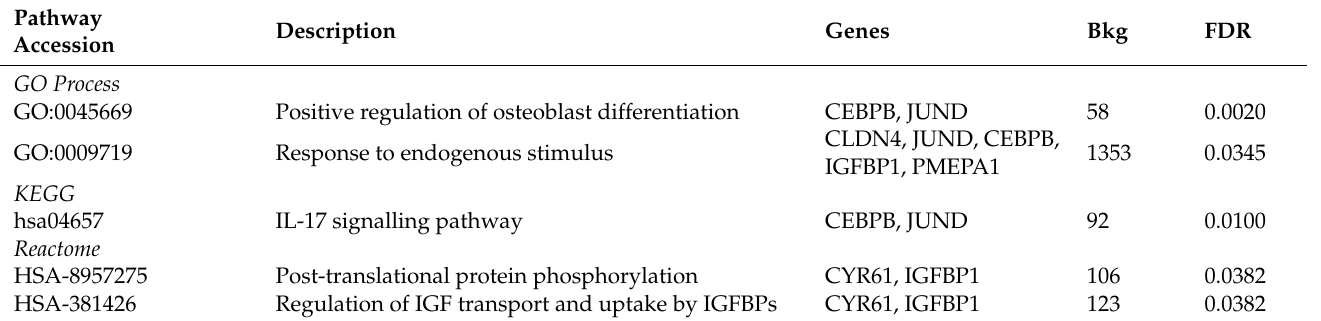
Table A9. Enriched pathways amongst upregulated PSC genes over pseudo-time. This Table summarises the pathways identified as being over-represented in the protein network presented in Figure A12. The pathways explored included Gene Ontology (GO) biological processes, KEGG pathways and Reactome pathways. Abbreviations: Bkg, Background (number of genes in the pathway). FDR, false discovery rate.